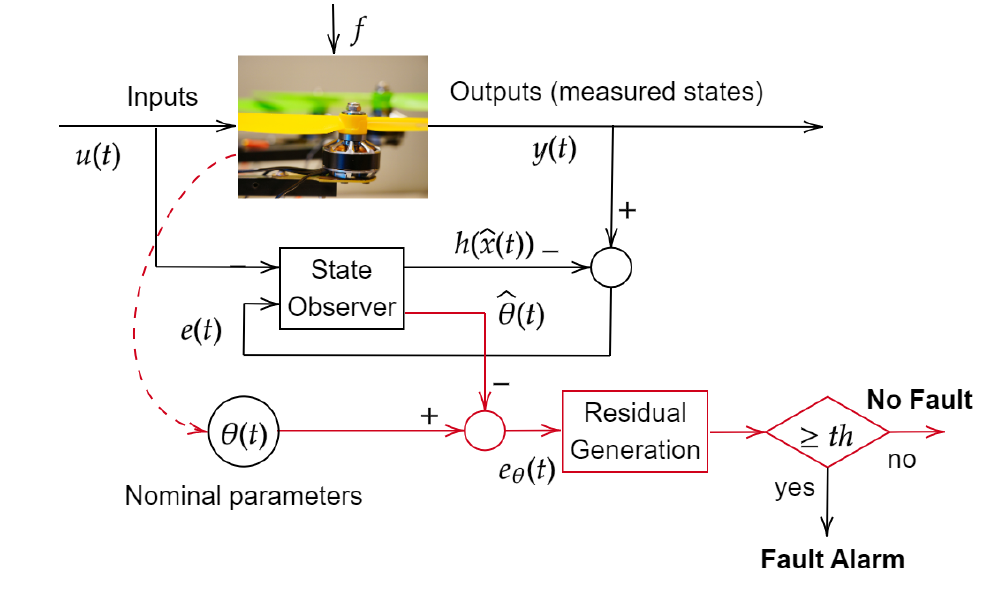
Figure 10. Methods based on parameters estimation, where u ( t ) and y ( t ) are the inputs and outputs (measured states) of the BLDC motor, respectively. e ( t ) is the observation (estimation) error, θ ( t ) represents the parameters in nominal (normal) operation conditions, h ( ˆ x ( t )) is the function output of the observer which is dependent on the estimated states, ˆ θ represents the estimated states, e θ ( t ) is the error between the nominal and estimated parameters and th is the threshold to surpass when there is a